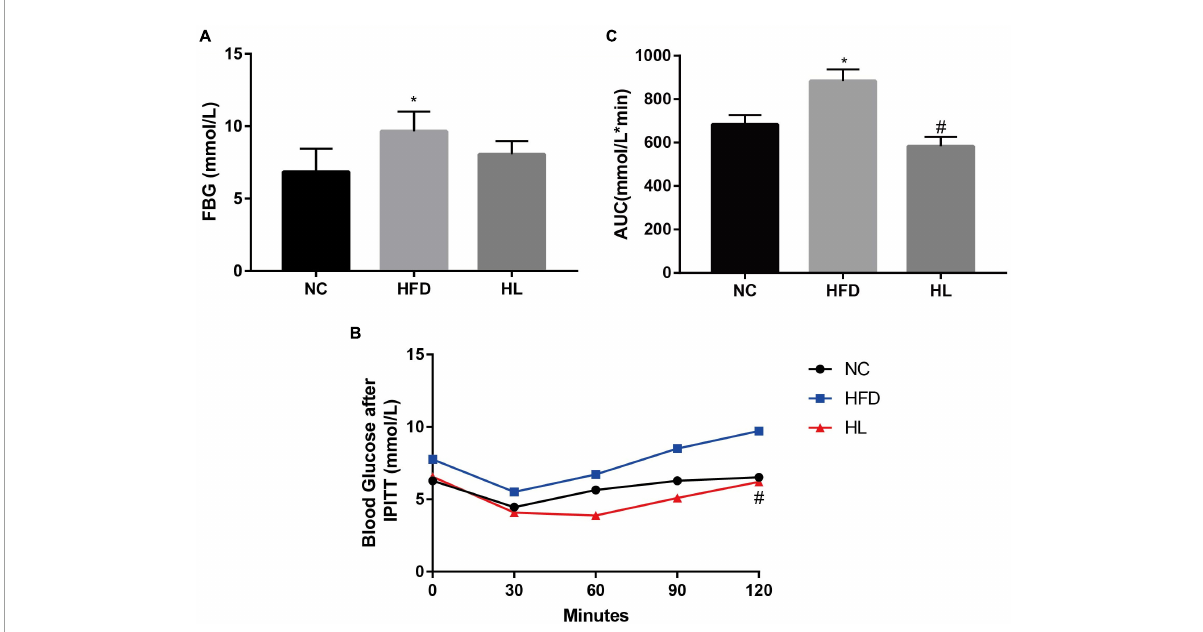
FIGURE2 Liraglutide reduced FBG and improved insulin sensitivity in HFD-fed mice. (A) Fasting blood glucose (FBG) levels. (B) Blood glucose after intraperitoneal insulin tolerance test (IPITT). (C) The area under the curve (AUC) of IPITT. Data are presented as the mean ± SEM. * p < 0.05 vs. NC group; # p < 0.05 vs. HFD